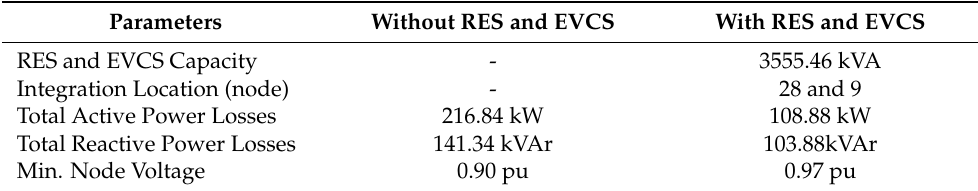
Table 3. Comparison of parameters with and without RES and EVCS.